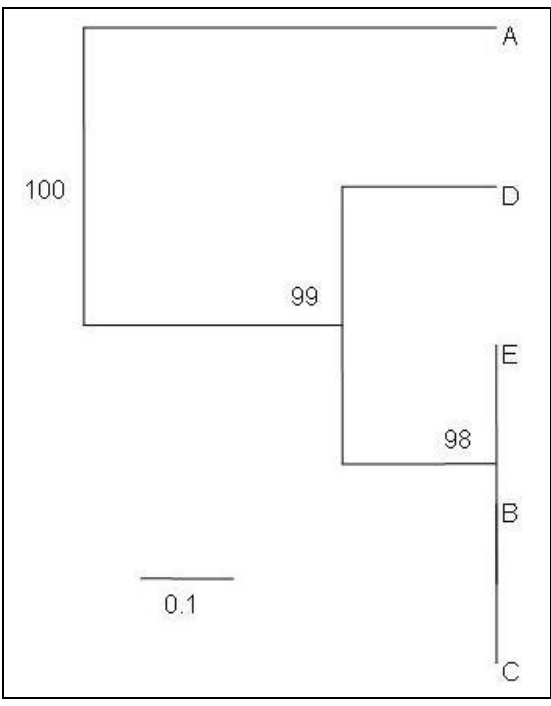
Figure 3. UPGMA tree constructed using the Jaccard method showing the relationships among isolated DNA using different lysis buffers based on RAPD profiles. Bootstrap values (expressed as percentages of 1000 replications) >50% are shown at branch